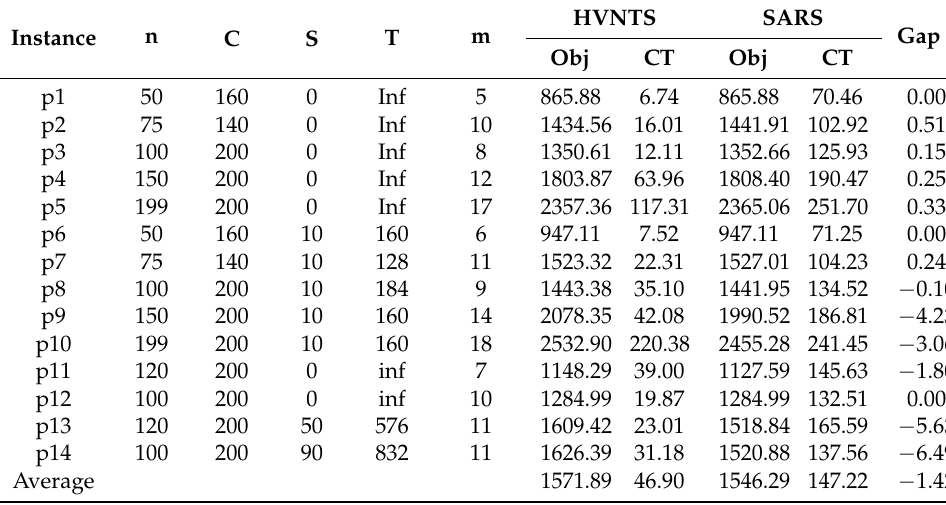
Table 4. Comparison between SARS and HVTNS on large PCP